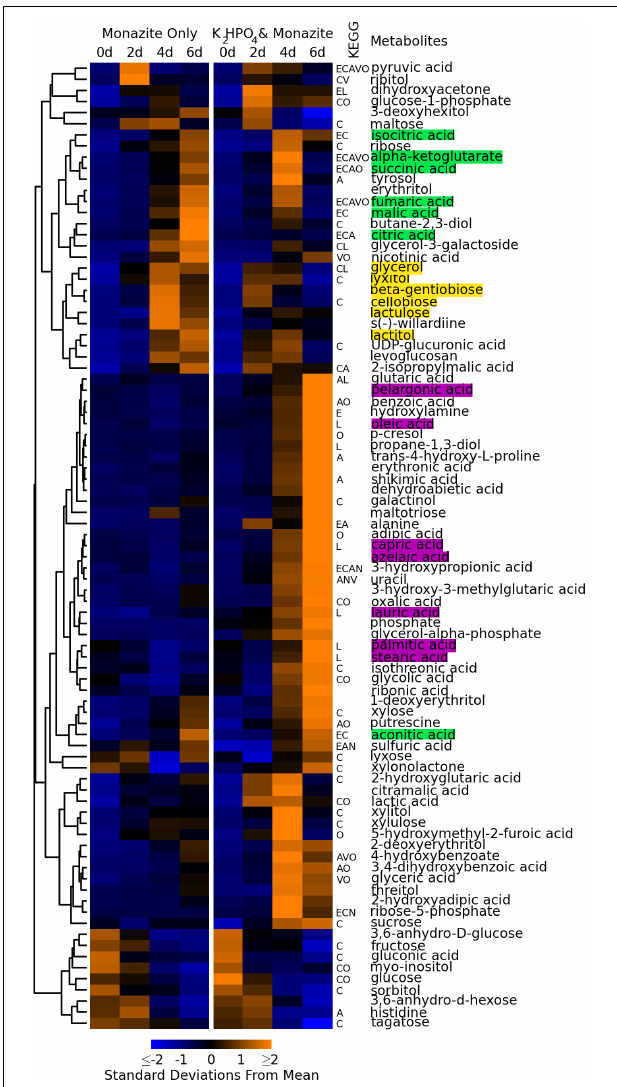
FIGURE 2 | Concentration profiles of identified metabolites. Heatmap shows average levels of identified metabolites detected during monazite bioleaching for each growth condition and time point. Columns represent different conditions and time points. Rows represent different metabolites. Metabolites are ordered based on hierarchical clustering, with the clustering dendrogram displayed to the left of the heatmap and metabolite names to the right. Heatmap colors indicate standard deviations below (blue) and above (yellow) the overall mean level for each metabolite. Letters between heatmap and metabolite names indicate KEGG pathways involving each metabolite. E = energy metabolism, C = carbohydrate metabolism, A = amino acid metabolism, L = lipid metabolism, N = nucleic acid metabolism, V = metabolism of cofactors and vitamins, O = other KEGG pathways. Metabolites highlighted in green are part of the TCA cycle. Metabolites highlighted in yellow are disaccharides and alcohols detected early in the growth cycle. Metabolites highlighted in purple are long chain ( > 8 carbon) fatty acids.